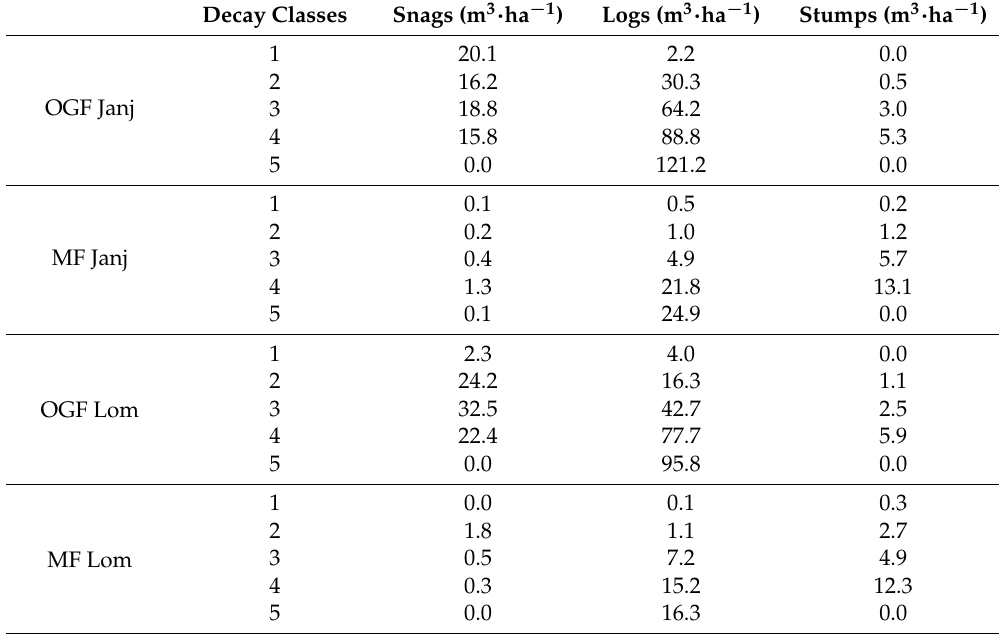
Table 3. Different decay classes of CWD in the studied old-growth (OGFs) and selection managed forests (MFs).